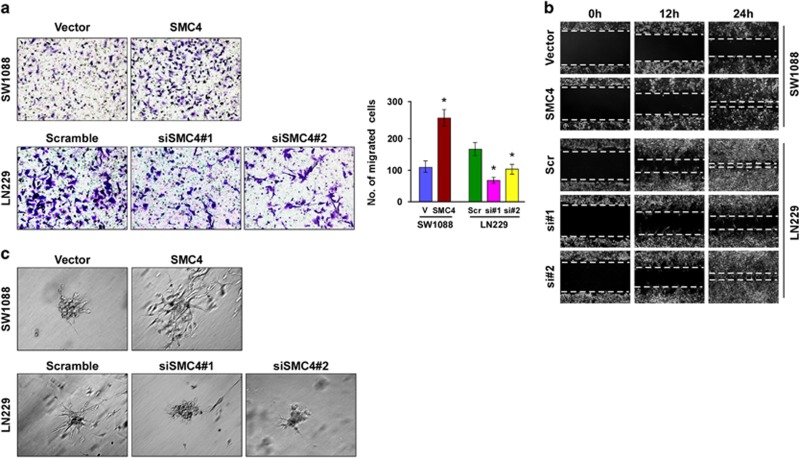
SMC4 promotes glioma cell migration and invasive capability in vitro. (a) Representative images (left, magnification, × 200) and quantification (right) of SW1088 and LN229 cell migration in the Transwell assay. The quantification of migrated cells is the mean of three independent experiments. Bars represent the mean±s.d. of three independent experiments. *P<0.05. (b) Wound-healing assay assessment of cell migration. (c) Representative micrographs of SW1088 and LN229 cells after 10-day culture in three-dimensional spheroid invasion assays, magnification, × 200. Scr, scramble.